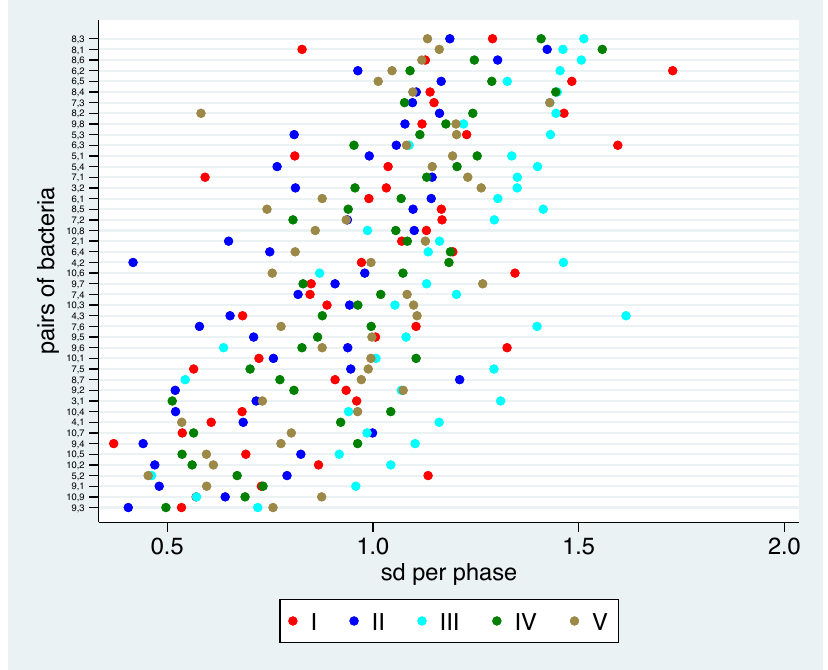
Figure 5. Standard deviations (sd) for phase-specific log ratios for all bacterial pairs of bacterial groups and phases based on empirical estimates. The pairs are sorted by the mean sd value over all